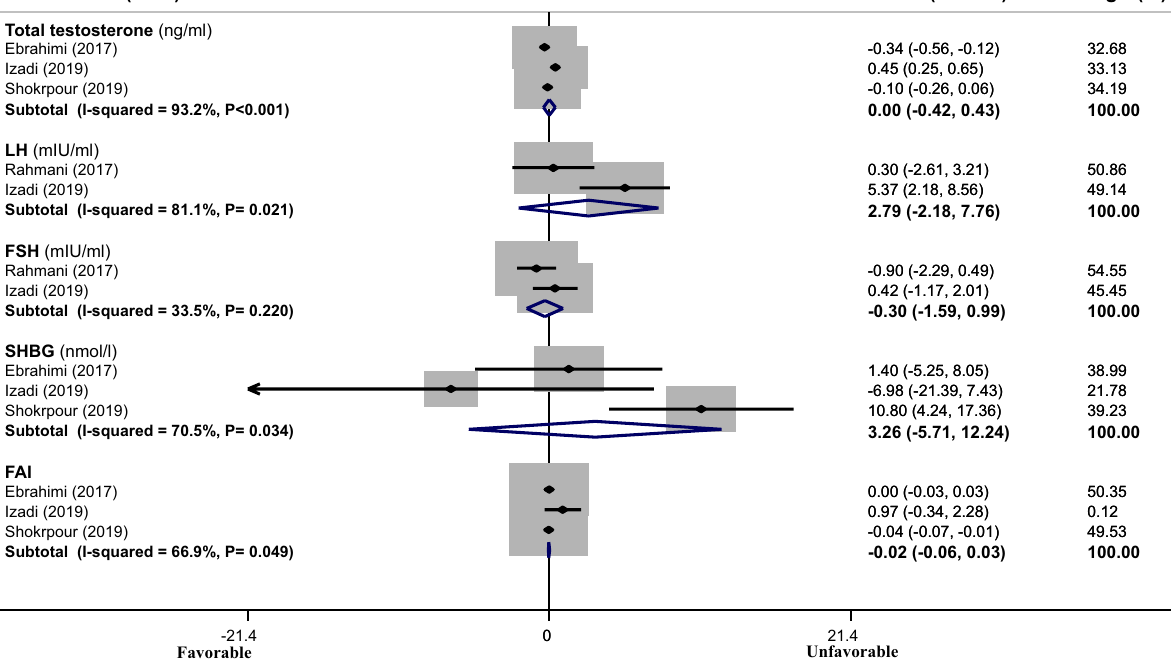
Figure 5. Forest plots of the effect of vitamin E supplementation or vitamin E along with omega-3 or magnesium supplementation on hormonal profile. If the diamond does not touch the vertical line (or the line of null effect), the overall effect is statistically significant. No significant effect of vitamin E supplementation or vitamin E plus omega-3 or magnesium supplementation on hormonal profile was found in PCOS